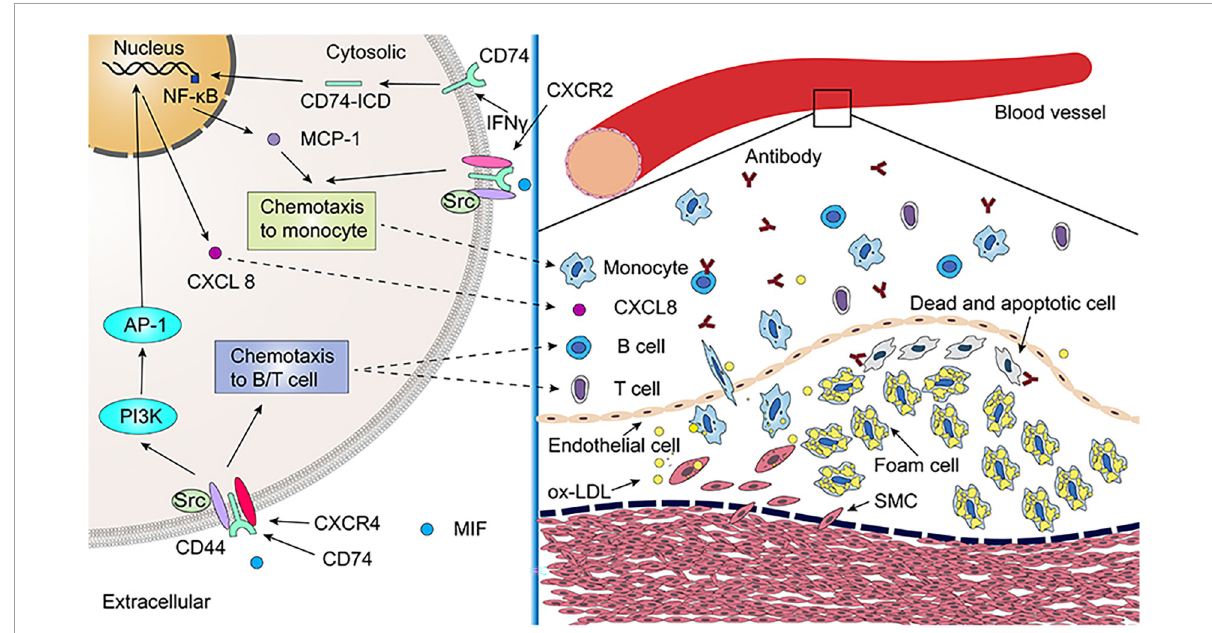
FIGURE4 The role of leukocyte differentiation antigen 74 (CD74) in atherosclerosis. Migration inhibitory factor (MIF) promotes monocyte chemotaxis via CXCR2/CD74/CD44 complex. The secretion of monocyte chemoattractant protein-1 (MCP-1) is promoted by inhibits atherosclerosis by reducing interferon-gamma (IFN γ ) inducing CD74/NF- κ B. The MIF/CXCR4/CD74/CD44 signaling pathway promotes B-cell and T-cell chemotaxis, which releases antibodies that neutralize ox-LDL and promote the clearance of dead and apoptotic cells in atherosclerotic lesions. Additionally, MIF promotes CXCL8 expression through CXCR4/CD74/CD44, which plays an important role in atherosclerosis. As of yet, it is unclear whether MIF2 contributes to atherosclerotic lesions. SMC, smooth muscle cell; ox-LDL, oxidized low density